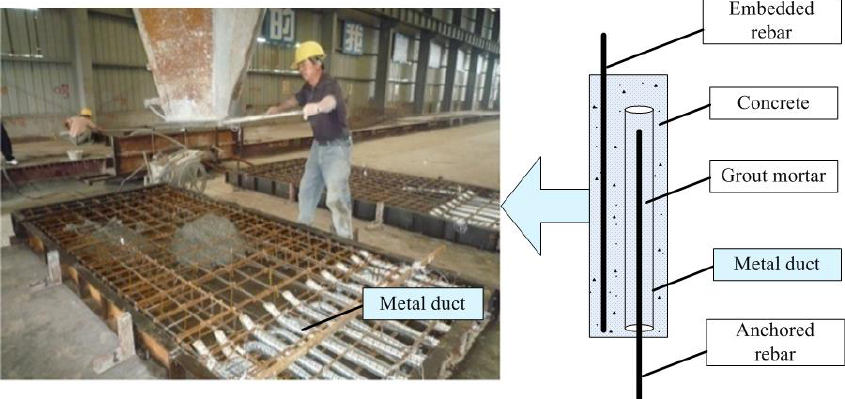
Figure 1. Corrugated metal duct connections [8].